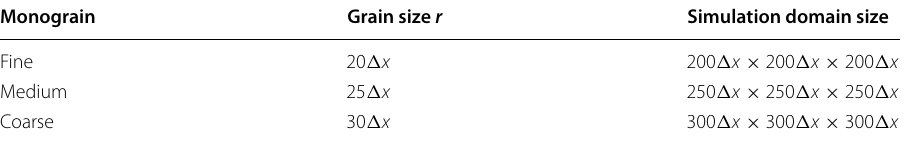
Table 1 Simulation domains corresponding to the initial grain size r of monograin for unconstrained growth